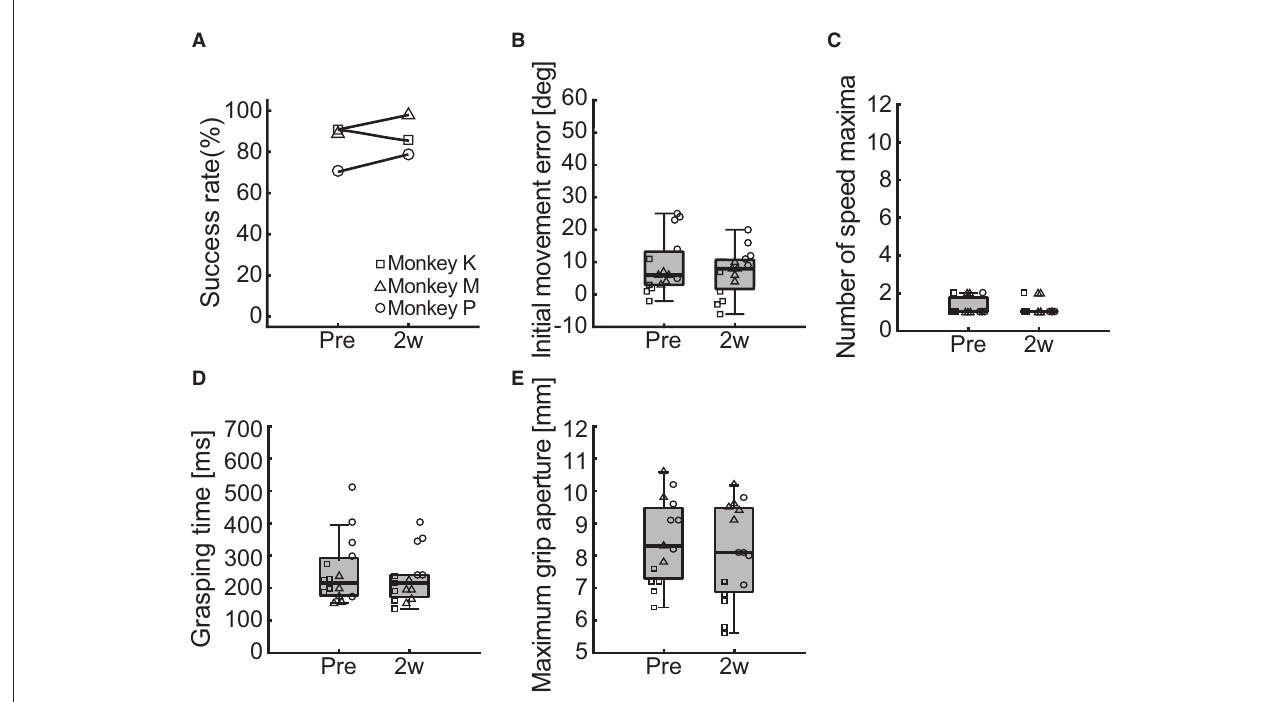
FIGURE7 Behavioral results of the ipsilesional forelimb function. (A) Changes in the success rate of the pellet-reaching task. (B–E) Changes in the indices of reaching and grasping function including initial movement direction error (B) , number of speed maxima (C) , grasping time (D) , and maximum grip aperture (E) . Box plots indicate the median (black line in the box), IQR (gray box), and the lowest and highest data within 1.5 IQR of the lower and upper quartile (error bars), respectively.